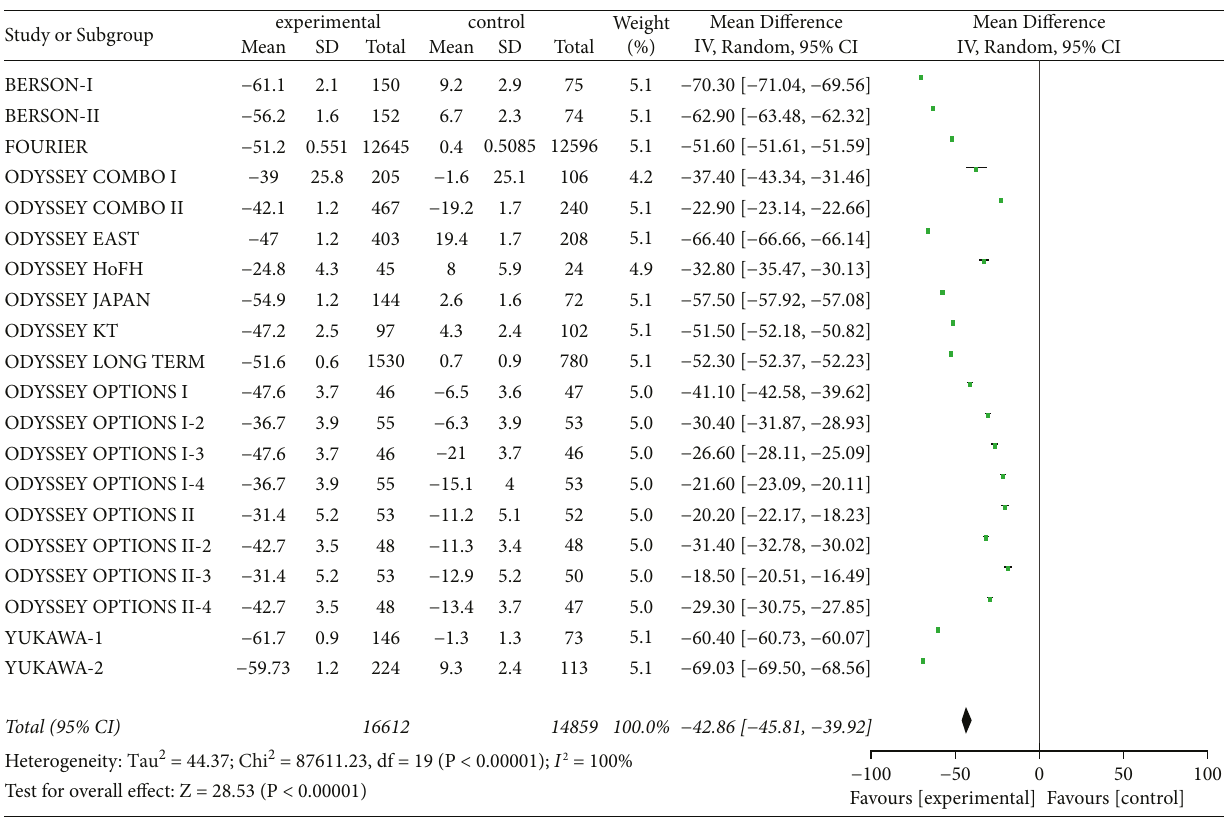
Figure 8: Comparison of the reduction of serum non-HDL-C (%) from baseline between control group and experimental